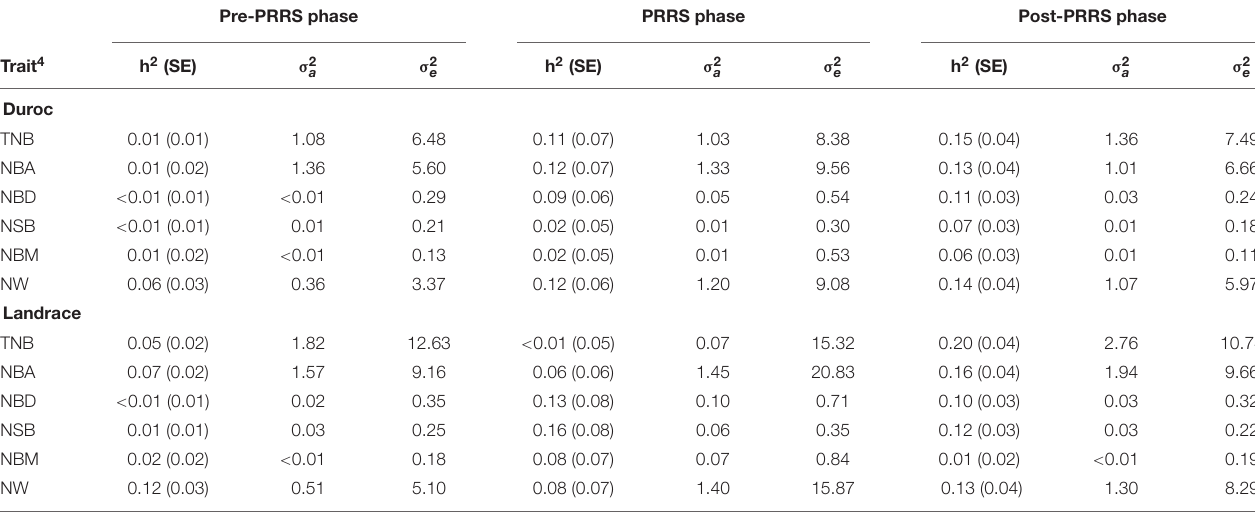
TABLE 5 | Estimates of genetic parameters 1 , 2 for reproductive traits by PRRS 3 phase and breed. Pre-PRRS phase